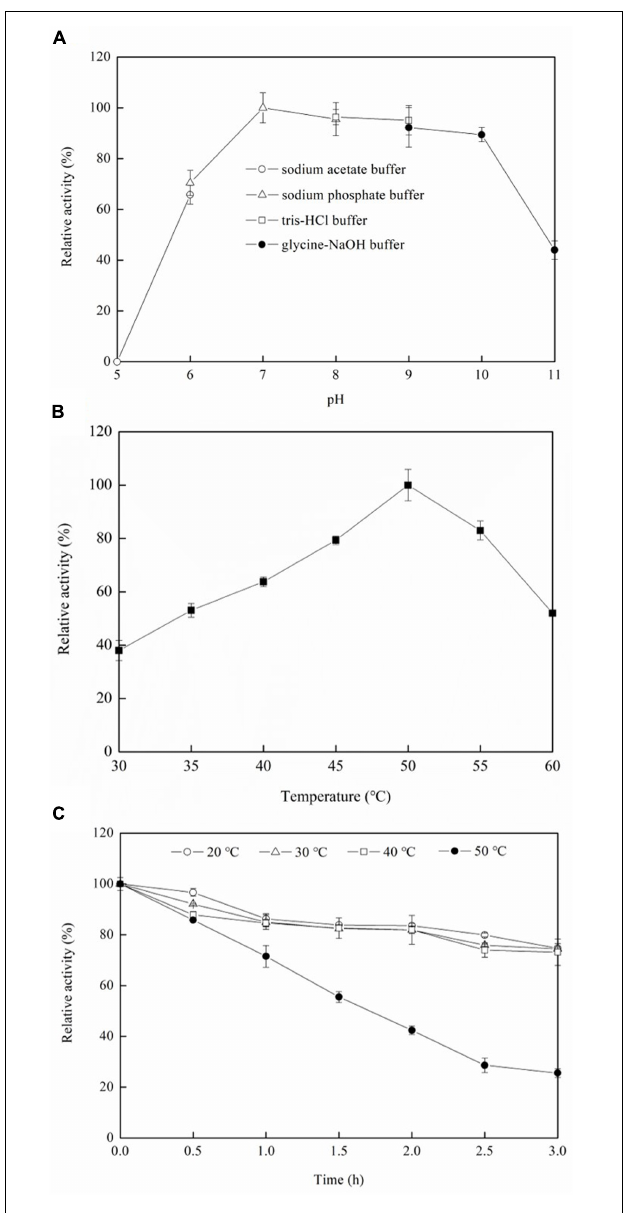
FIGURE 5 | Effects of pH (A) and temperature (B) on the ADH activities, and the thermal stability of the ADH (C) . The conditions for obtaining the highest enzyme activity were set to 100%.